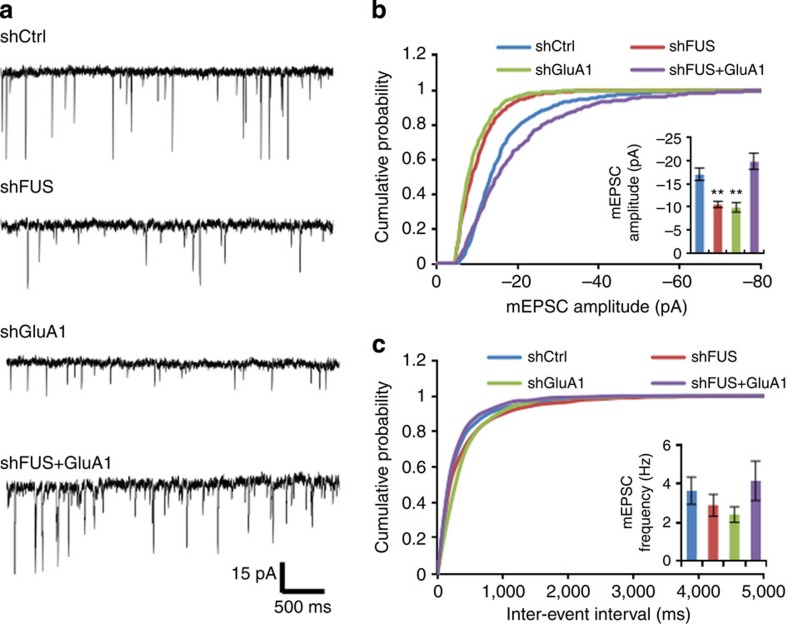
FUS knockdown neurons exhibit reduced AMPA receptor surface expression and mEPSC amplitude.(a) Representative mEPSC sample traces from the control (n=9), FUS knockdown (n=8), GluA1 knockdown (n=4) and FUS knockdown with GluA1 expression (n=5) cultured cortical neurons. One to three cells per separate culture were used for experiments. Calibration: 15 pA, 500 ms. (b, c) Cumulative distributions of mEPSC amplitude (b) and frequency (c) from the control, FUS knockdown, GluA1 knockdown and FUS knockdown with GluA1 expression cultured cortical neurons. The insets show mean±s.e.m. for mEPSC amplitude (F(3, 22)=12.50, P<0.0001, one-way analysis of variance (ANOVA); shCtrl versus shFUS: **P=0.0028, shCtrl versus shGluR1: **P=0.0084, Tukey's test post hoc; b) and frequency (F(3, 22)=0.8617, P=0.4756, one-way ANOVA; c).